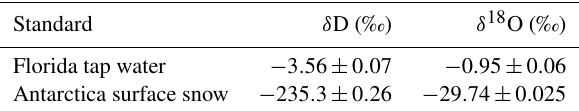
Table B2. Isotope standards used for Picarro calibrations. Standard δ D (‰) δ 18 O